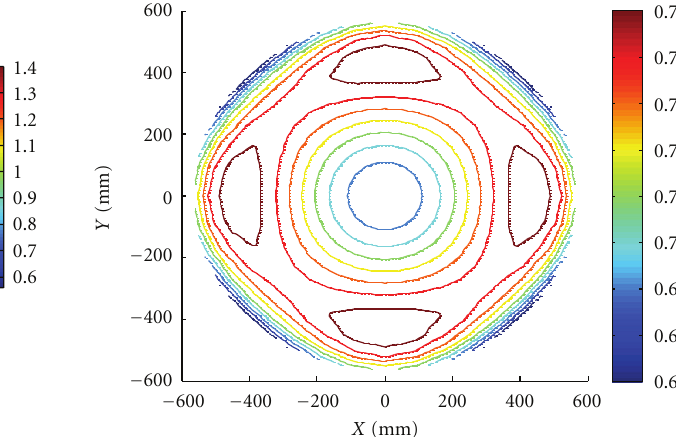
Figure 6: DSI μ Y .